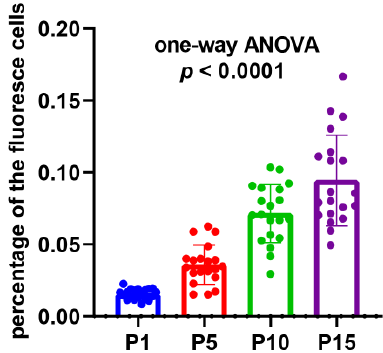
Figure 7. The percentage of the fluorescence cells in all the mycelial cells in different subcultured Figure7. Thepercentageofthefluorescencecellsinallthemycelialcellsindifferentsubculturedgenerations. generations. Twenty replicates were included in each generation and the p- value of one-way Twenty replicates were included in each generation and the p- value of one-way ANOVA < ANOVA < 0.0001.